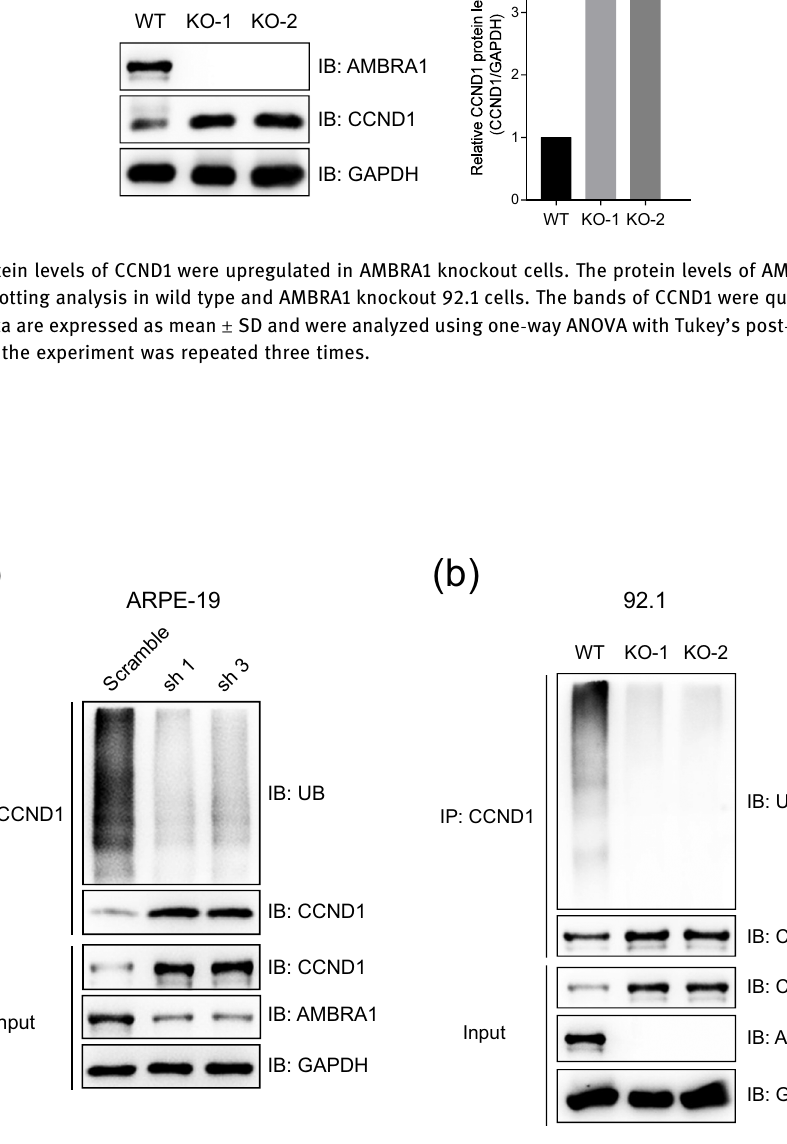
Figure A4: The ablation of AMBRA1 attenuates the ubiquitination of endogenous CCND1. ( a ) The knockdown of AMBRA1 attenuated the ubiquitination of endogenous CCND1. The lysates of ARPE - 19 cells stably expressing AMBRA1 shRNAs were immunoprecipitated with anti - CCND1 antibody and subjected to immunoblotting analysis using indicated antibodies. ( b ) The knockout of AMBRA1 attenuated the ubiquitination of endogenous CCND1. The lysates of wild type and AMBRA1 knockout 92.1 cells were immunoprecipitated with anti - CCND1 antibody and subjected to immunoblotting analysis using indicated antibodies.